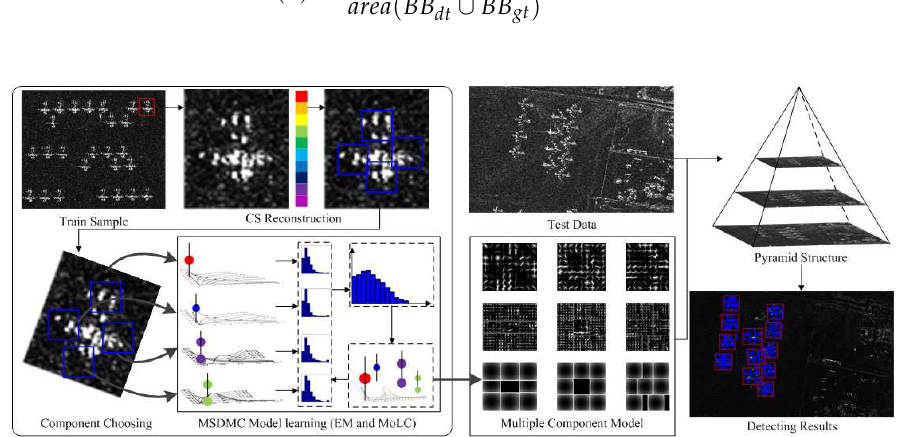
Figure 2. Framework of the mixture statistical distribution-based multiple-component model (MSDMC).